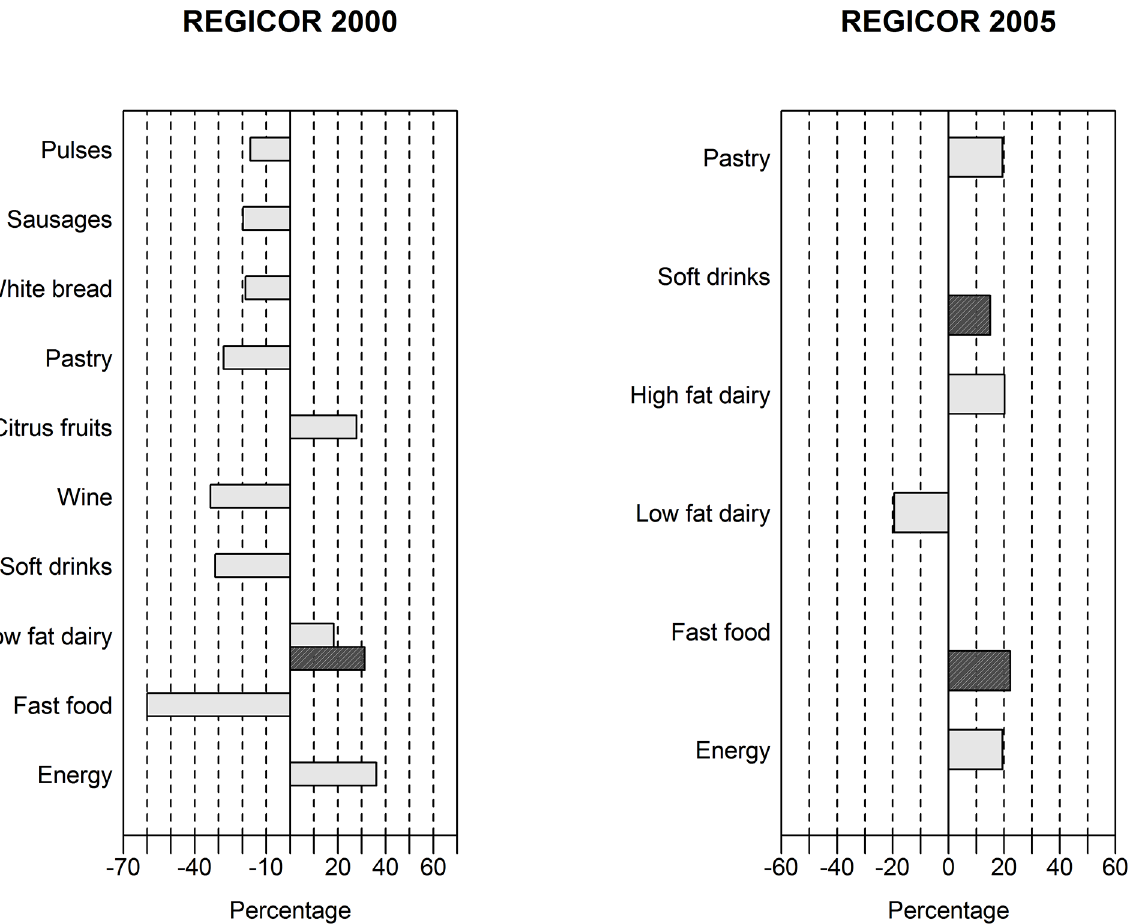
Fig 1. Meaningful * percentage changes in absolute intake of food group consumption in grams in plausible energy reporters after excluding energy under-reporters within 1) the REGICOR 2000 and 2) the REGICOR 2005 surveys. Only groups of food are included, which had meaningful changes. White — mixed dietary patter, black — western dietary pattern. * (cid:1) 15% difference in food group consumption in plausible energy reporters compared with all reporters.